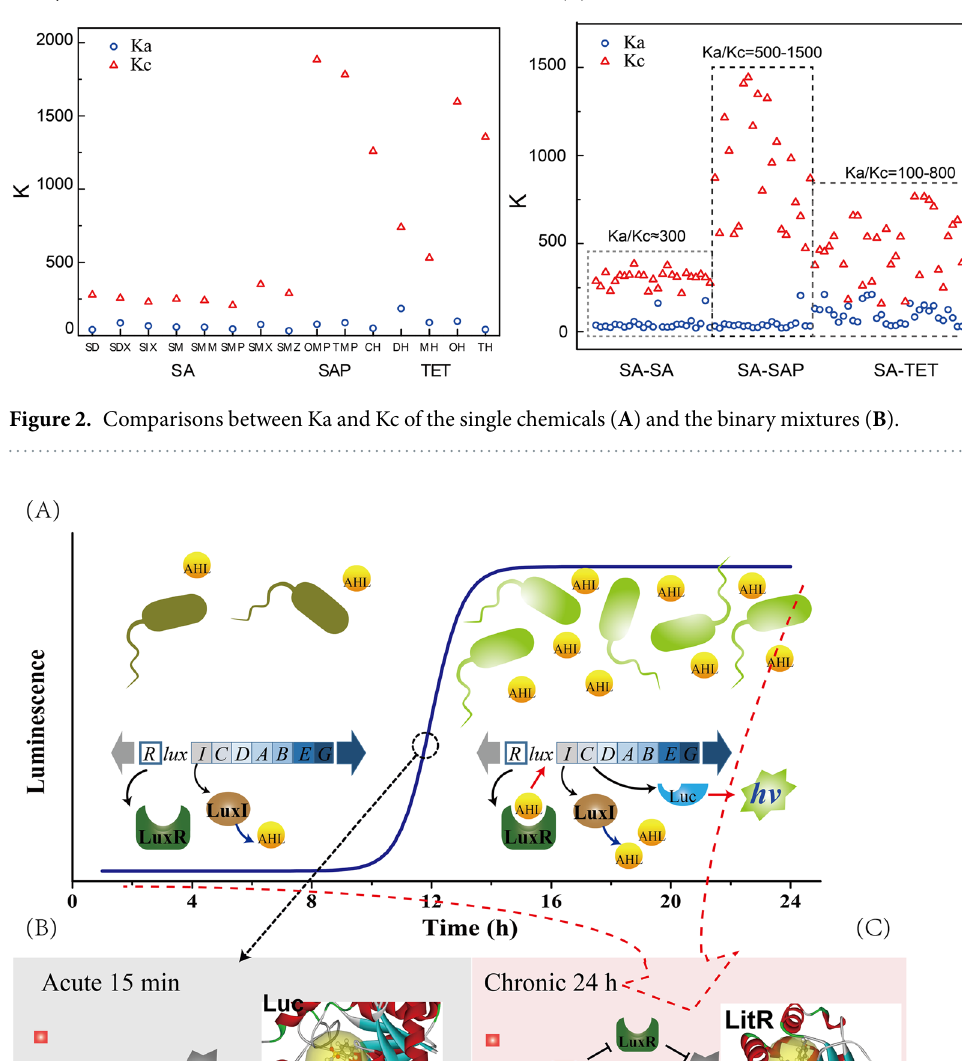
the chronic test takes 24 h, during which the bacteria grow from extremely low density to high density (stationary phase), as shown in Figure S1 in the supporting information. During this period, the antibiotics could on the one hand bind with their target proteins 26 (DHPS, DHFR and 16S rRNA, respectively), killing or inhibiting the bac- terial growth, on the other hand affect the bacterial QS communications (see Figure S2 for detailed information on QS of V . fischeri ). The expression of the QS-related genes was determined upon exposure to SCP in the chronic toxicity, in order to investigate its influence on the bacterial QS communication. As depicted in Fig. 4, SCP presented concentration-dependent inhibition on the expression of litR , luxR , and dhps . This suggested that the bacte- rial QS communication were considerably influenced by the exogenous drugs. The decrease in the luxR mRNA expression was probably induced by the depression on the litR expression, since the litR locates in the upstream of lux genes. In light of this, the actions on the LitR proteins by the antibiotics were actually prior to their actions on the LuxR (Fig. 3C). Therefore, the influences of the antibiotics on the LuxR proteins can be represented by